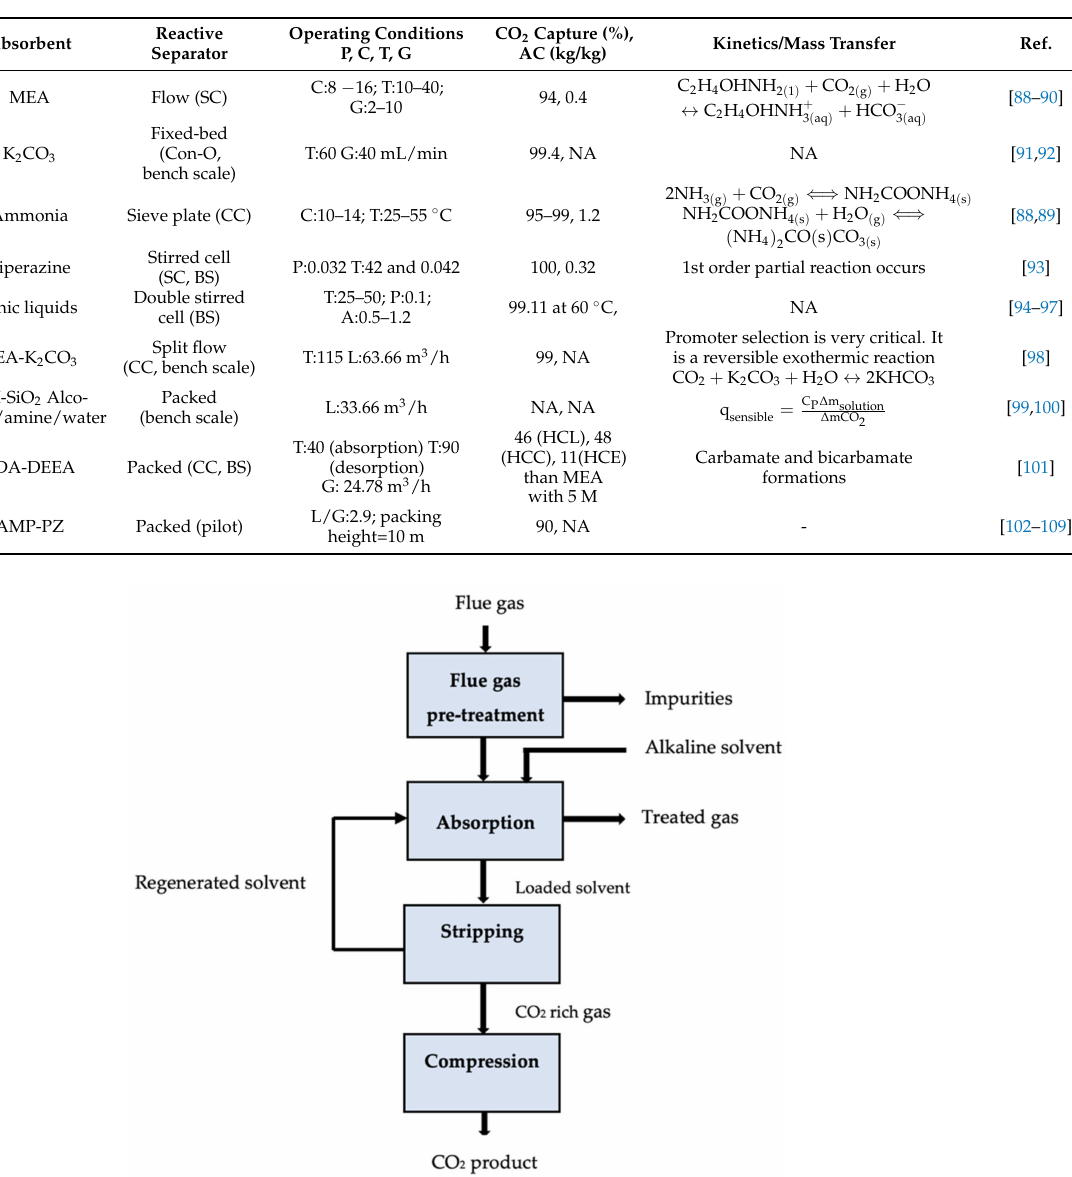
Table 3. Summary of absorption-based carbon capture.